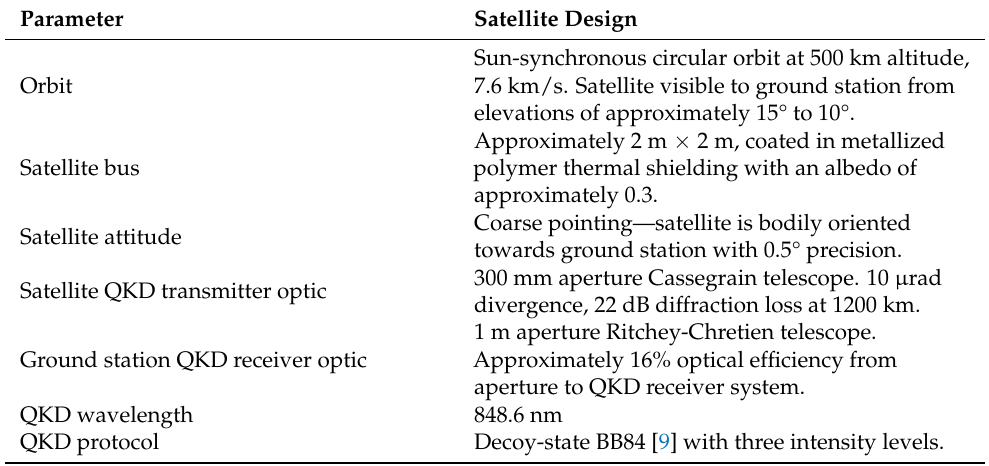
Table 1. QKD satellite design assumptions based on Micius